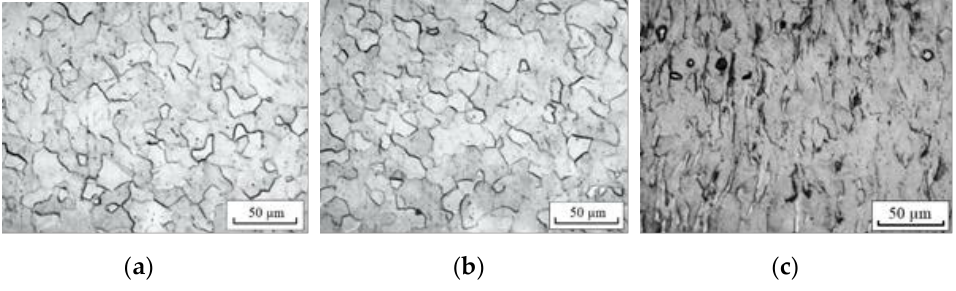
Figure 6. Microstructure of CG titanium tested by heating with a dryer, 200 °C: a — undeformed zone; b — deformed zone; c — neck. Table 3. The element content in the particles